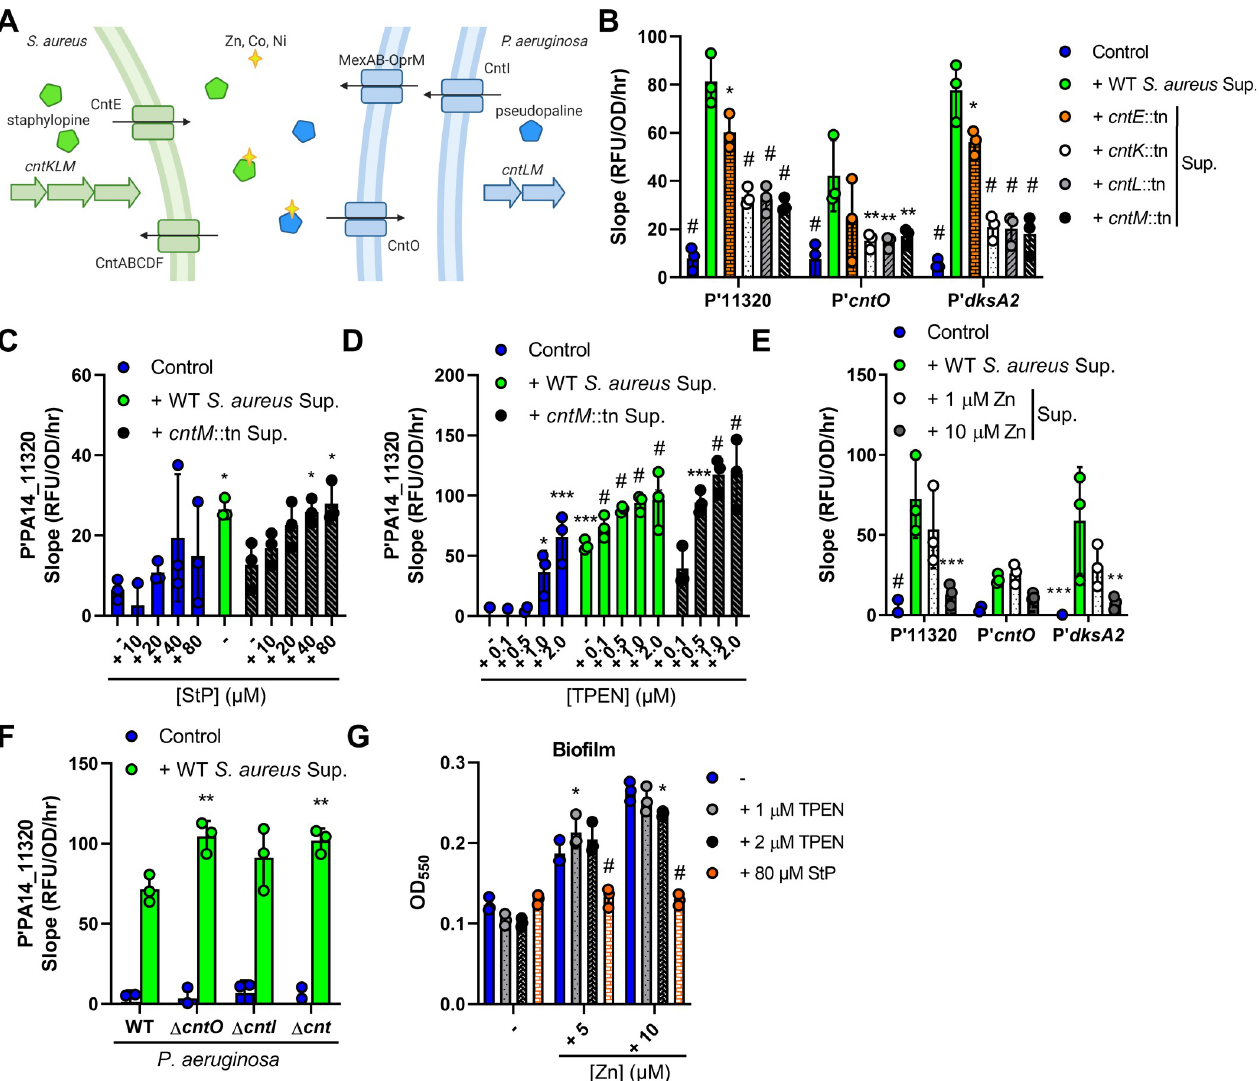
Fig 3. The S . aureus metallophore StP is sensed by P . aeruginosa . (A) Screening of the NTML identified mutants in the biosynthesis and secretion of StP as deficient in the induction of the PA14_11320 promoter. Schematic shows StP (green pentagon) and PsP (blue pentagon) biosynthesis, export, binding to transition metals Zn, Co, Ni, and uptake. (B–F) RFU of mScarlet normalized to OD 600 over time from 1.5 to 5 hours after exposure to media control or S . aureus WT or cnt supernatant and/or addition of the indicated concentrations of StP, Zn, or TPEN in the indicated P . aeruginosa WT or mutant promoter- reporter strains (promoters of PA14_11320, cntO , or dksA2 ). (G) P . aeruginosa cultures were grown in medium alone or with the additives listed, and biofilm formation was assessed by crystal violet staining after 24 hours of growth. Data shown for all panels are the means of 3 independent biological replicates. Datasets were analyzed by 2-way ANOVA with Tukey test for multiple comparisons (significance shown for comparisons to: B, WT supernatant; F, respective WT sample, respectively) or 1-way ANOVA with Dunnett test for multiple comparisons to the respective control (E, WT supernatant; C, D, and G, respective media control). The error bars denote the SD. � , p < 0.05; �� , p < 0.01; ��� , p < 0.001; #, p < 0.0001. The data underlying panels B–G can be found in S1 Table. NTML, Nebraska Transposon Mutant Library; PsP, pseudopaline; RFU, relative fluorescence unit; SD, standard deviation; StP, staphylopine; WT, wild type.